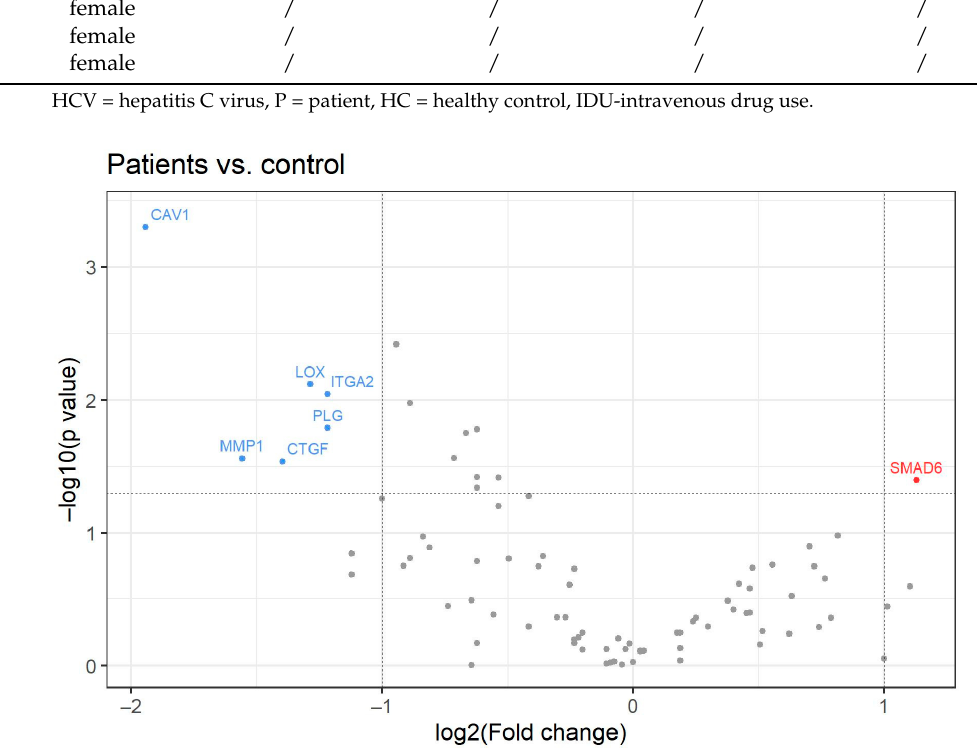
Figure 1. Volcano plot for 84 analyzed genes. The X-axis shows the log2 value of the fold change between values for patients with chronic hepatitis C compared to healthy controls. The Y-axis represents − log10 p -value. Red points symbolize overexpressed genes and blue points represent underexpressed genes. The horizontal line shows the threshold where p = 0.05. Table 2. Gene expression patterns in patients with chronic hepatitis C and controls. P-values are corrected for multiple testing with Benjamini–Hochberg method.